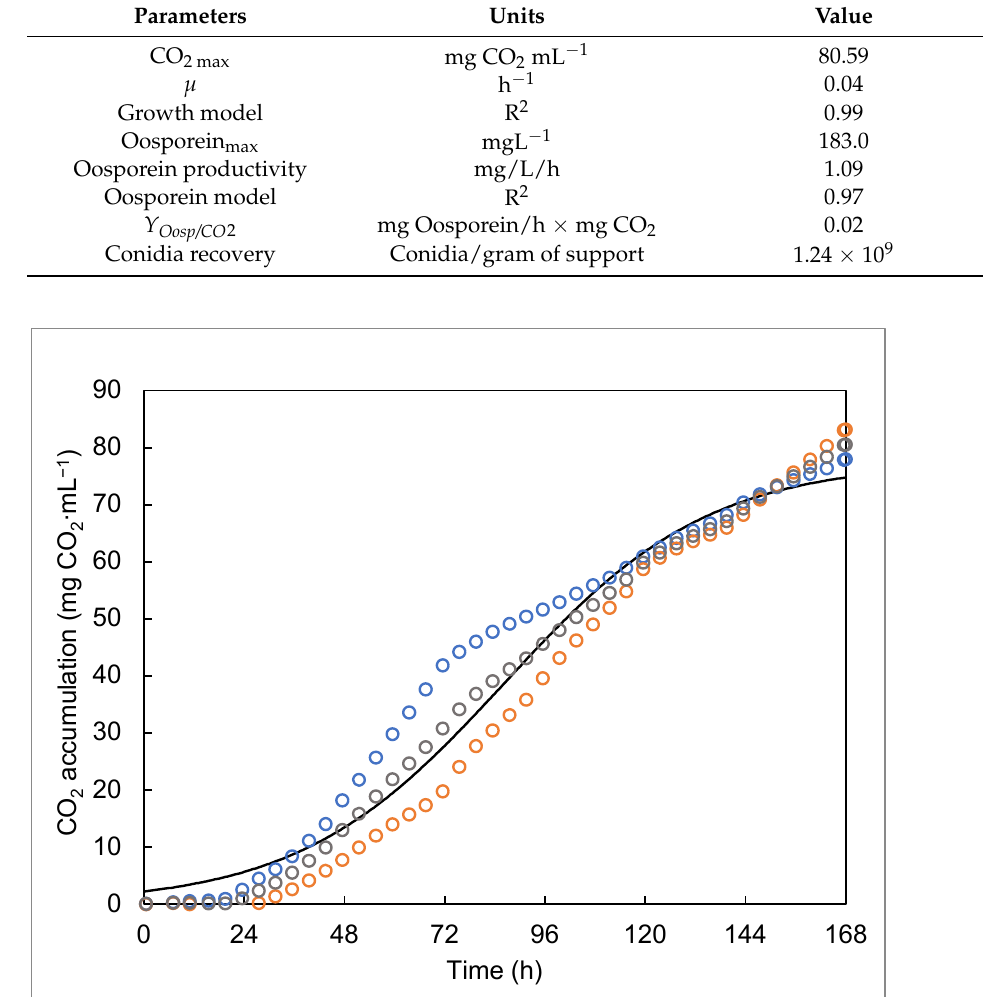
Table 2. Kinetic parameters of Beauveria bassiana PQ2 under biofilm bioreactor conditions.